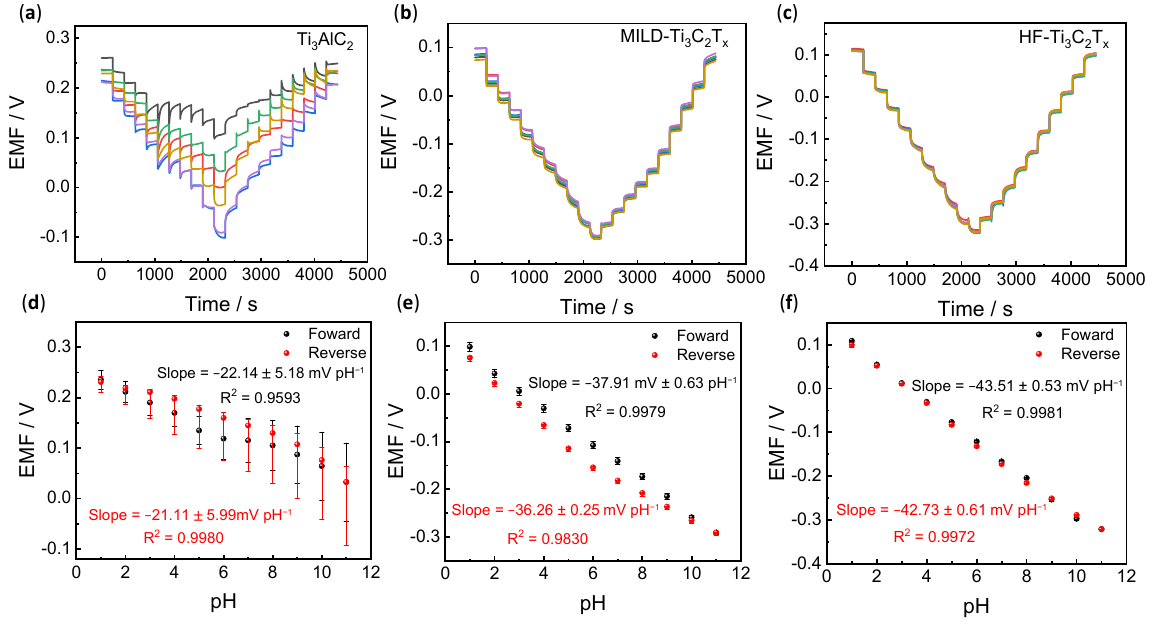
Figure 3. Potentiometric pH responses. ( a – c ) Examination of pH reversible responses for Ti 3 AlC 2 , MILD-Ti 3 C 2 T x and HF-Ti 3 C 2 T x . All tests have been performed on six individual electrodes as shown in different colors ( n = 6). ( d – f ) pH response calibration curves for the three types of pH electrodes. Corresponding sensitivities for the forward (pH = 1–11) and reverse (pH = 11–1) tests are shown in the